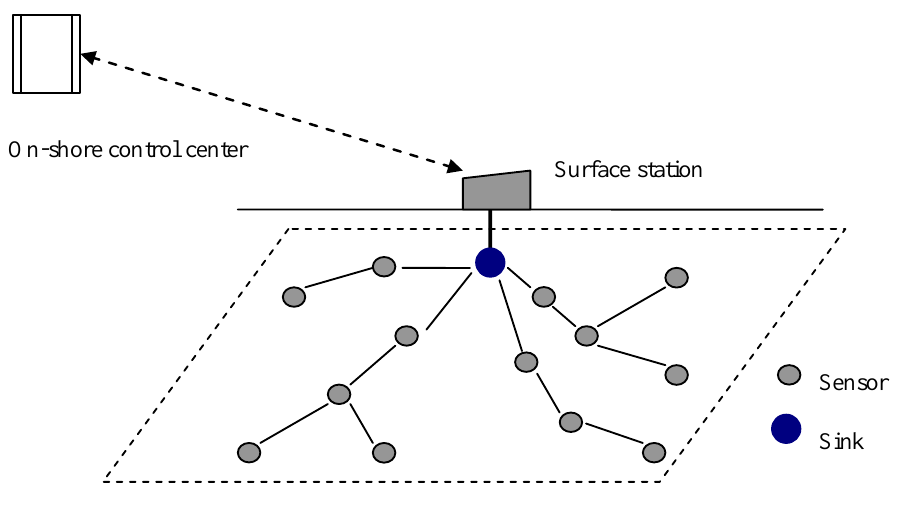
Figure 1. Network architecture.